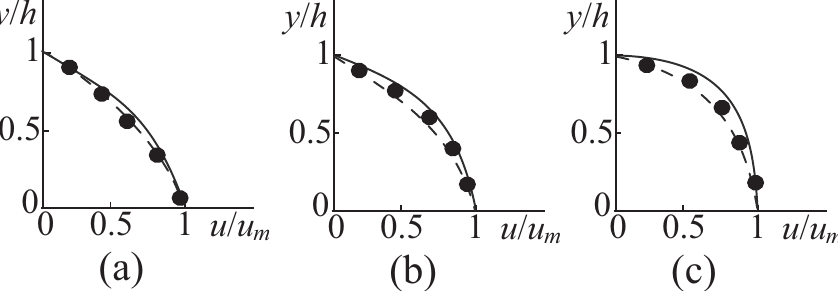
Figure 2. Axial velocity profiles in a channel for x / h = 5 ( a ); 15 ( b ); 30 ( c ). Solid lines correspond to the results of numerical simulation [20], dashed lines correspond to vortical flow described by Equation (1), and symbols bullet correspond to experimental data